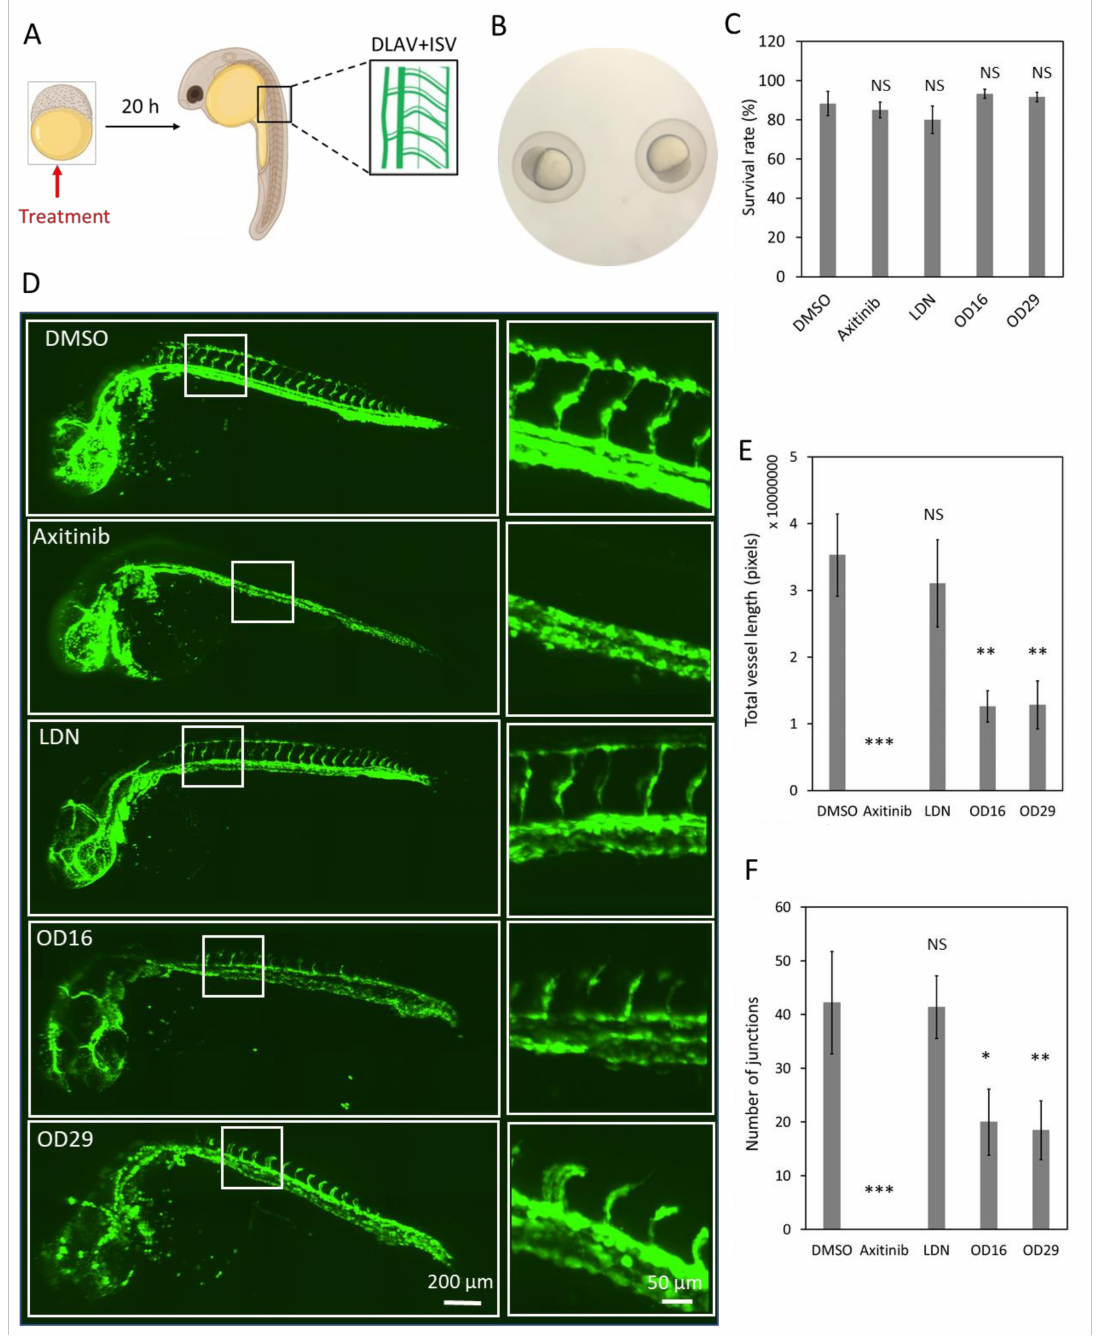
Figure 5. OD16 and OD29 partially inhibit DLAV and ISV formation in zebrafish embryos. ( A ) Schematic representation of the experimental procedure. The compounds were administered to the 2.5 hpf Tg ( fli :EGFP) zebrafish eggs, and DLAV and ISV vascularization was analyzed after 20 h treatment. ( B ) Representative image of the selected zebrafish embryos that were at the same development stage (around 2.5 hpf). ( C ) Toxicity assessment of the compounds in zebrafish embryos. The